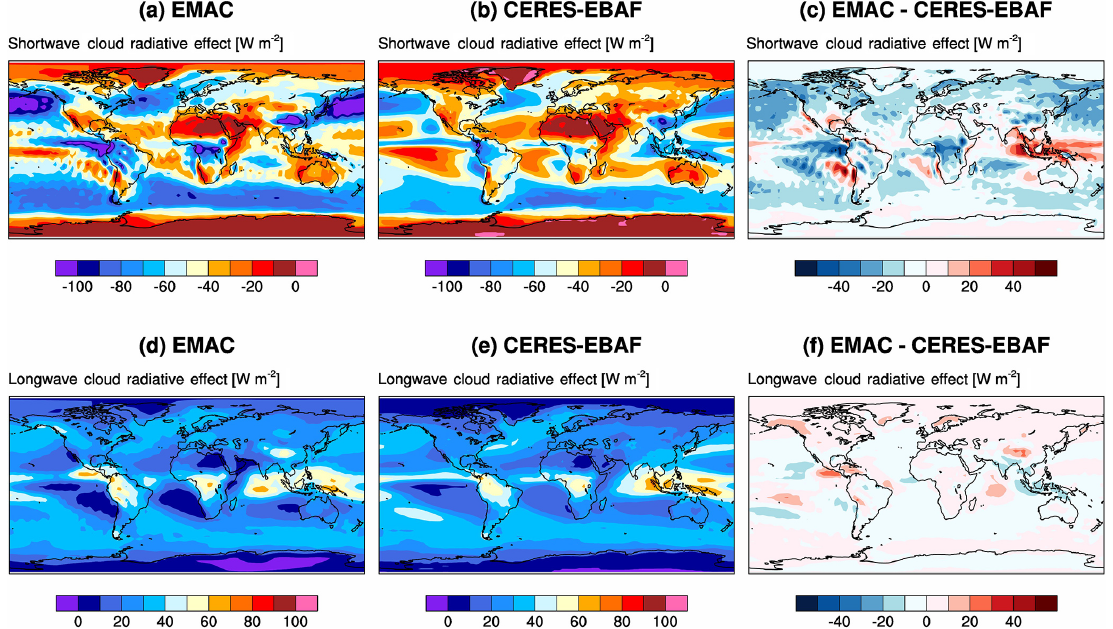
Figure 8. Similar to Fig. 2 but for radiation variables: shortwave (a–c) and longwave cloud radiative effects (d–f) . Satellite data are averaged over the 2003–2015 time